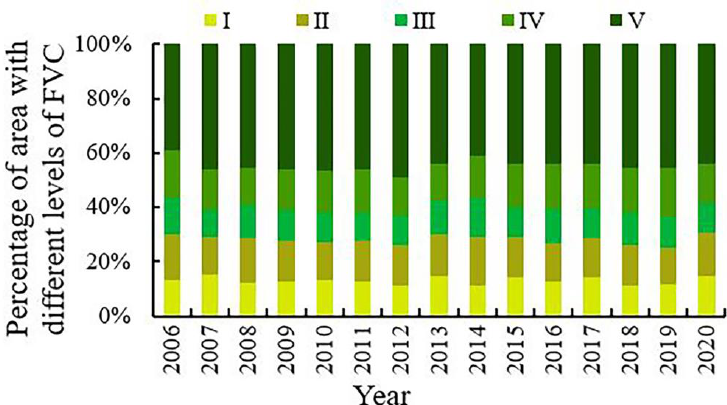
Figure 7. Interannual variation of different classes of vegetation, where I is Very Low FVC; II is Low FVC; III is Medium FVC; IV is Medium High FVC; V is High FVC. This is the same in Figure 8.